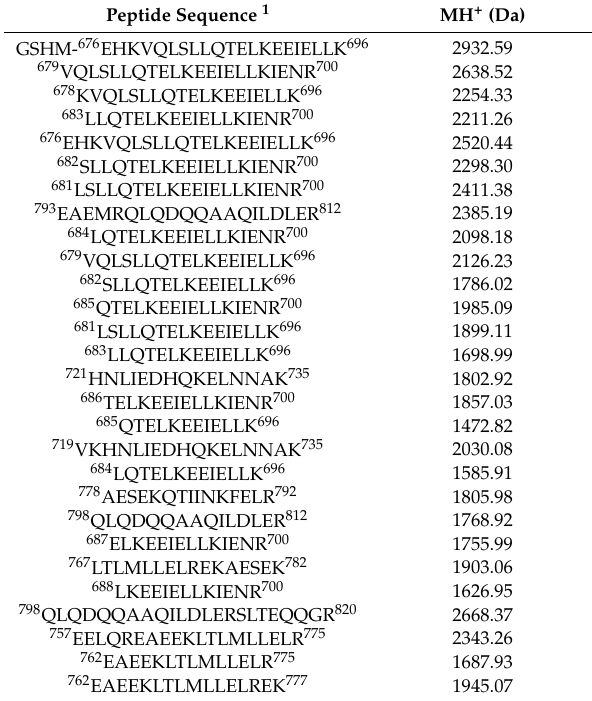
Table 2. List of peptide fragments found from mass spectrometry analysis of the crystallized PCNT CC2.